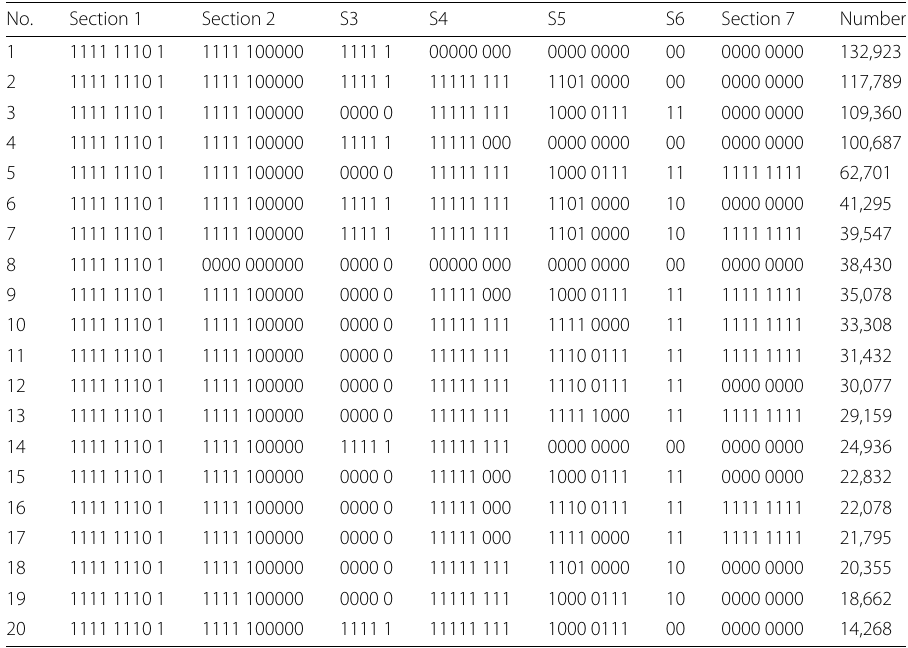
Table 1 Most frequent questionnaire paths: IPUMS International Malawi 2008 Census sample dataset